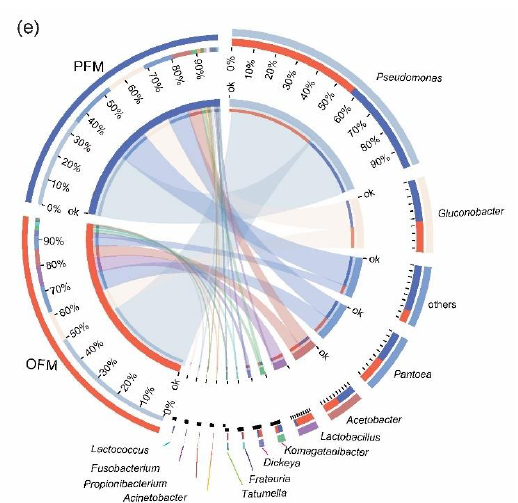
Figure 2. Common bacteria among populations of the same moth and between peach fruit moth (PFM) Carposina sasakii and the oriental fruit moth (OFM) Grapholita molesta . ( a ) Composition of 11 core genera found in four populations of PFM collected from di ff erent orchards. ( b ) Venn diagram at the genus level of PFM in four populations of PFM. ( c ) Composition of six core genera found in five populations of OFM collected from di ff erent orchards. ( d ) Venn diagram at the genus level of OFM from five populations of OFM. Moth species, collection location and host were provided in brackets following the four-letter sample code (Table 1). ( e ) The co-occurrence relationships of core bacteria between the PFM and OFM. In summary, Proteobacteria was the most abundant phylum for both host species. There were many common bacteria, such as the genus Pseudomonas , Gluconobacter , Acetobacter and Pantoea . In